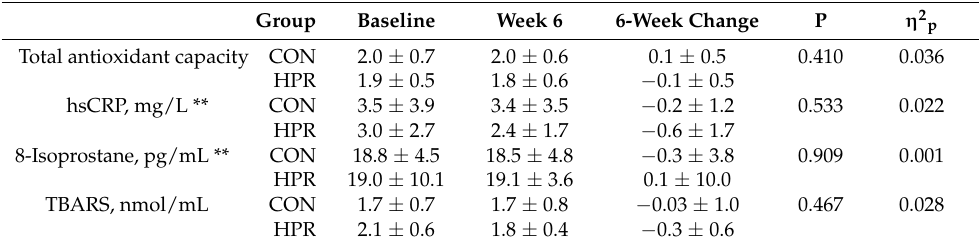
Table 5. Antioxidant capacity and inflammation indices in fasting blood at baseline and at week 6, and 6-week change data, in overweight adults following an energy-restricted diet composed of traditional breakfast cereal and gluten-free pasta dishes at lunch and dinner (CON; n = 11) or high-protein breakfast cereal and high-protein pasta dishes at lunch and dinner (HPR; n = 10) *